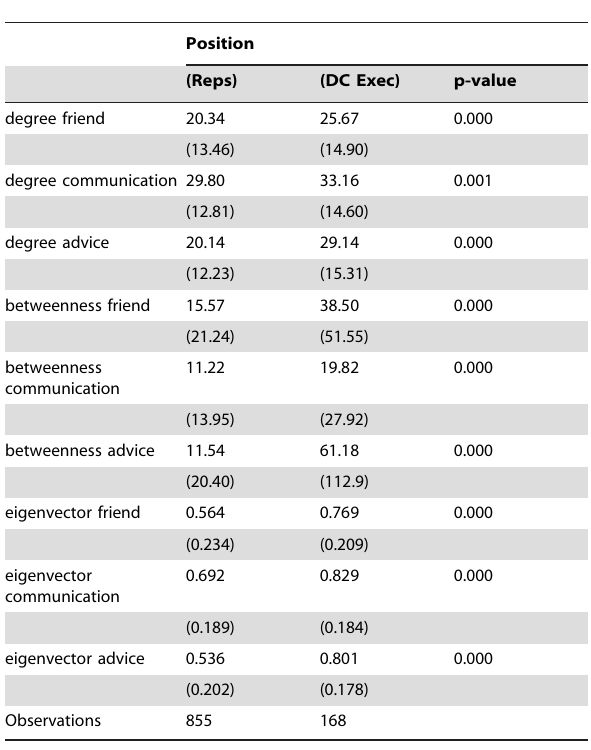
Table 2. Network centrality by leadership position.